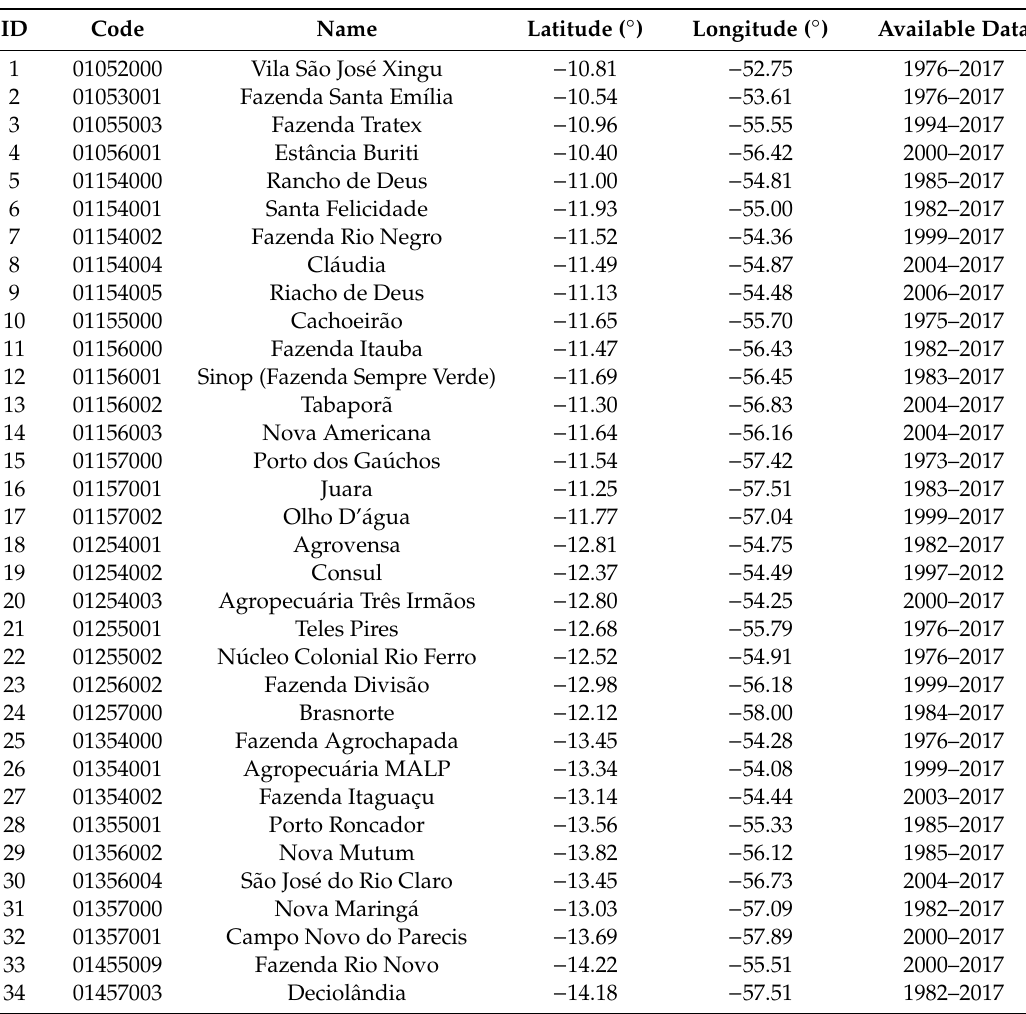
Table A1. Information related to the rain gauge stations used in the